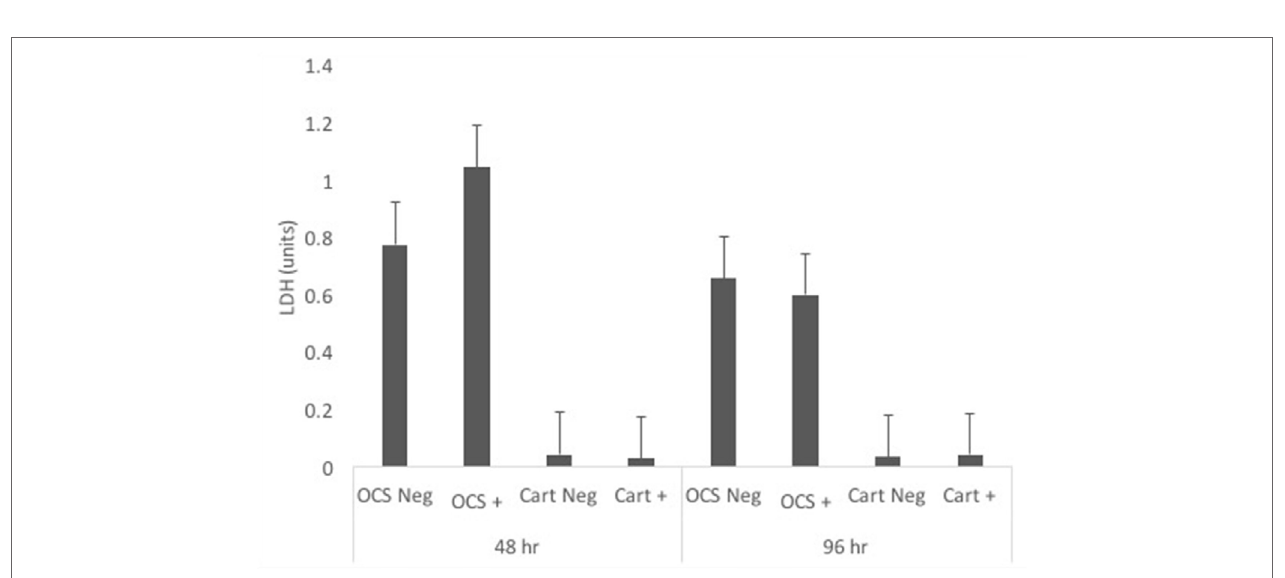
FigUre 6 | Mean ± SE concentrations of lactate dehydrogenase (LDH) in media samples of cultures containing osteochondral and synovial explants (OCS) or cartilage explants alone (Cart) that were unstimulated (Neg) or stimulated with IL-1 (10 ng/mL; + ) at 48 and 96 h after initiation of